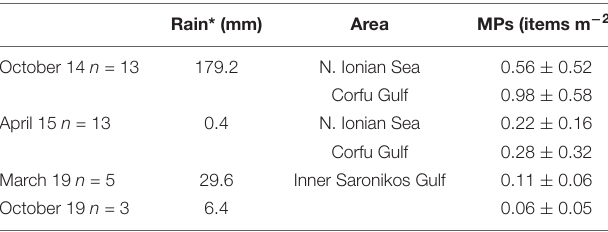
TABLE 1 | Microplastics (MPs) concentrations (items m − 2 ) in the areas with repetitive samplings and rain (mm) during 10 days before samplings. Rain* (mm)